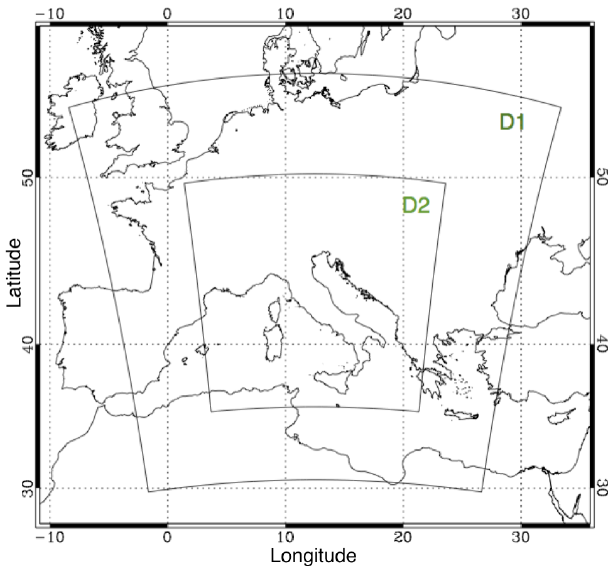
Figure 1. Model domains. The second domain has a 4km horizontal resolution, and it is nested in the first domain, at 12km horizontal resolution, using one-way